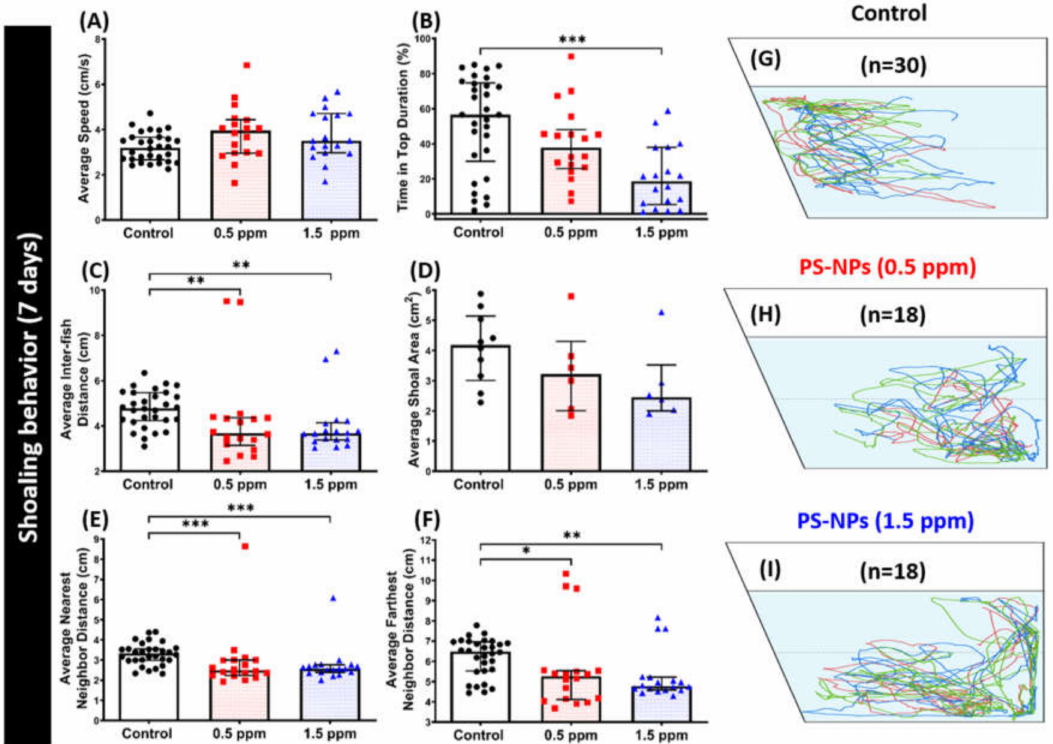
Figure 6. Shoaling behavior endpoint comparisons between the control and polystyrene nanoplastics (PS-NPs)-exposed zebrafish groups after a ~7-day exposure. ( A ) Average speed, ( B ) time in top duration, ( C ) average inter-fish distance, ( D ) average shoal area, ( E ) average nearest neighbor distance, and (F) average farthest neighbor distance, were analyzed. Groups of three fish were tested for shoaling behavior. The 1 min. locomotion trajectories for the control, 0.5 and 1.5 ppm PS-NPs exposed fish in shoaling tests were presented in G , H , I , respectively. The data are expressed as the median with interquartile range were analyzed by a Kruskal–Wallis test, which continued with Dunn’s